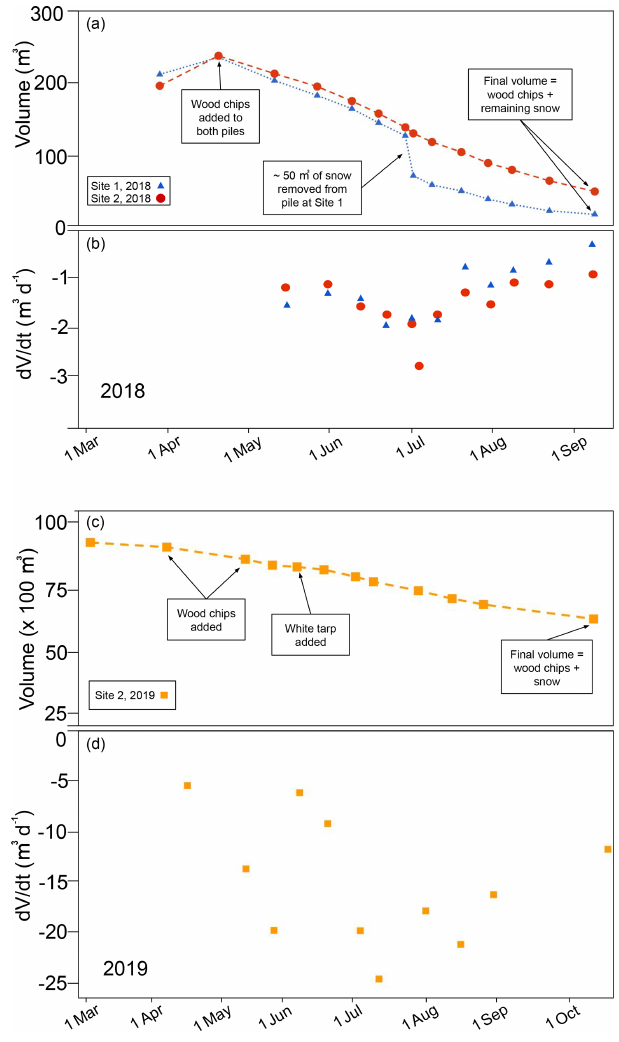
Figure 7. Volume change over time for snow piles at sites 1 and 2 measured by terrestrial laser scanning. (a) Volume of snow piles from placement in March 2018 until September 2018. Addition of woodchips in April and removal of snow in July at pile 1 shown by black arrows. Volumes are total, including woodchips. (b) Change in volume per unit time between surveys. The rate of volume loss increases midsummer for both piles. Site 1 received about 24m 3 of woodchips, while Site 2 received about 42m 3 of woodchips – this difference is due to pile geometry and the resulting difference in surface area. Site 1 snow was banked against the side of a hill, while the Site 2 pile was a hemisphere in the middle of an open de- pression. (c) Volumes of snow pile (2019) beginning in March and ending in October. Addition of woodchips throughout May and ad- dition of white tarp are indicated by black arrows. Volumes include woodchip volume. (d) Change in volume per unit time between sur-